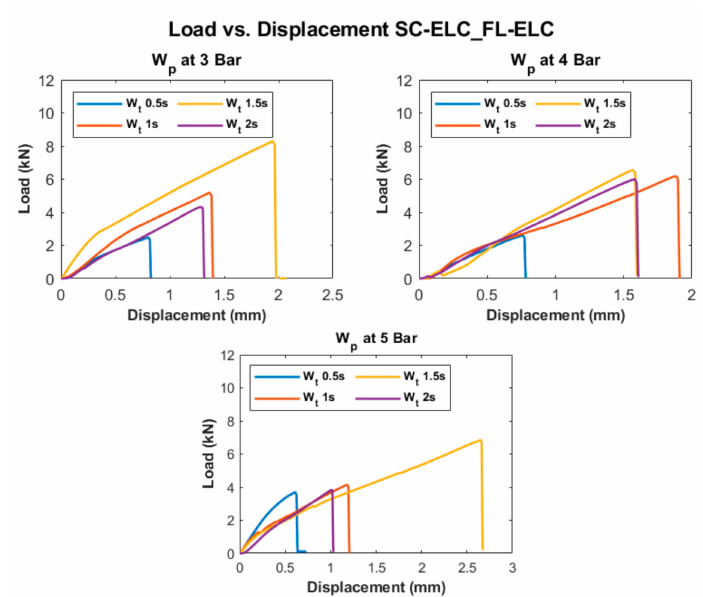
Figure 11. Load vs. displacement curves of SC-ELC_FL-ELC configuration at di ff erent welding